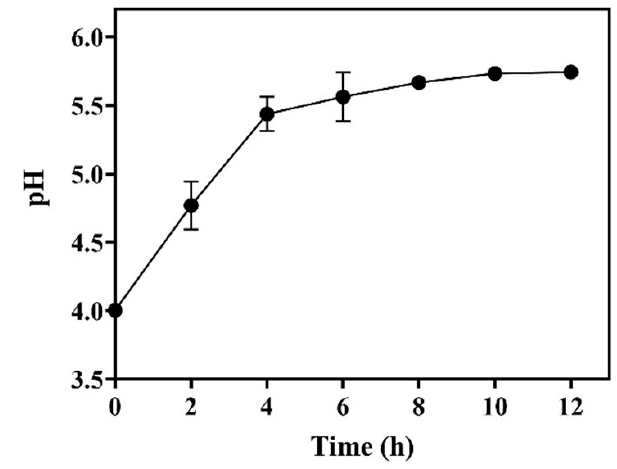
Figure 6. Time course of pH in whole-cell catalysis ( n = 3).